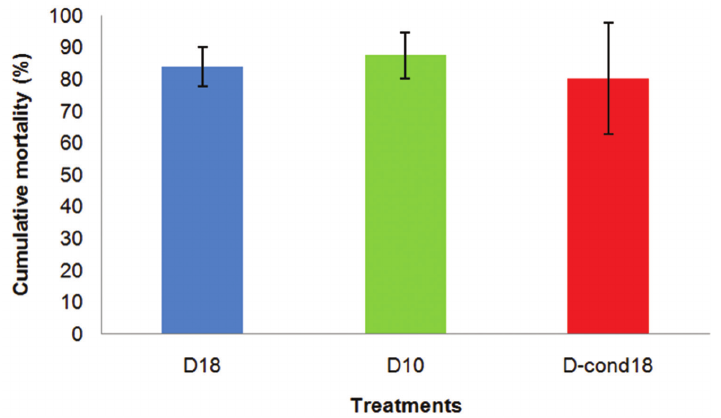
Figure 2. Mean ( ± SD) of the cumulative percentage of mortality in each desiccation treatment at day 50 after rehydration ( n = 15 observations). No significant differences were found between the desiccation treatments ( p > 0.01; ANOVA).